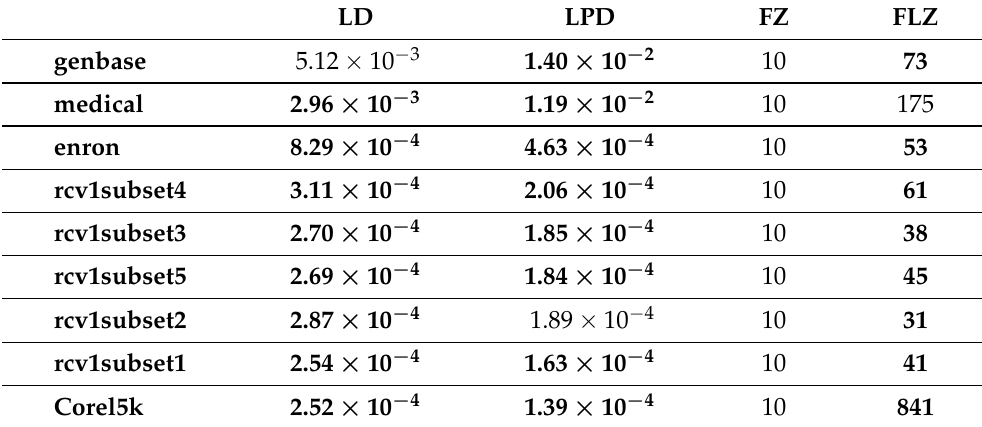
Table 9. Evaluation of the MOEA approach considering the constraint. In bold the results that are better than the Stratification